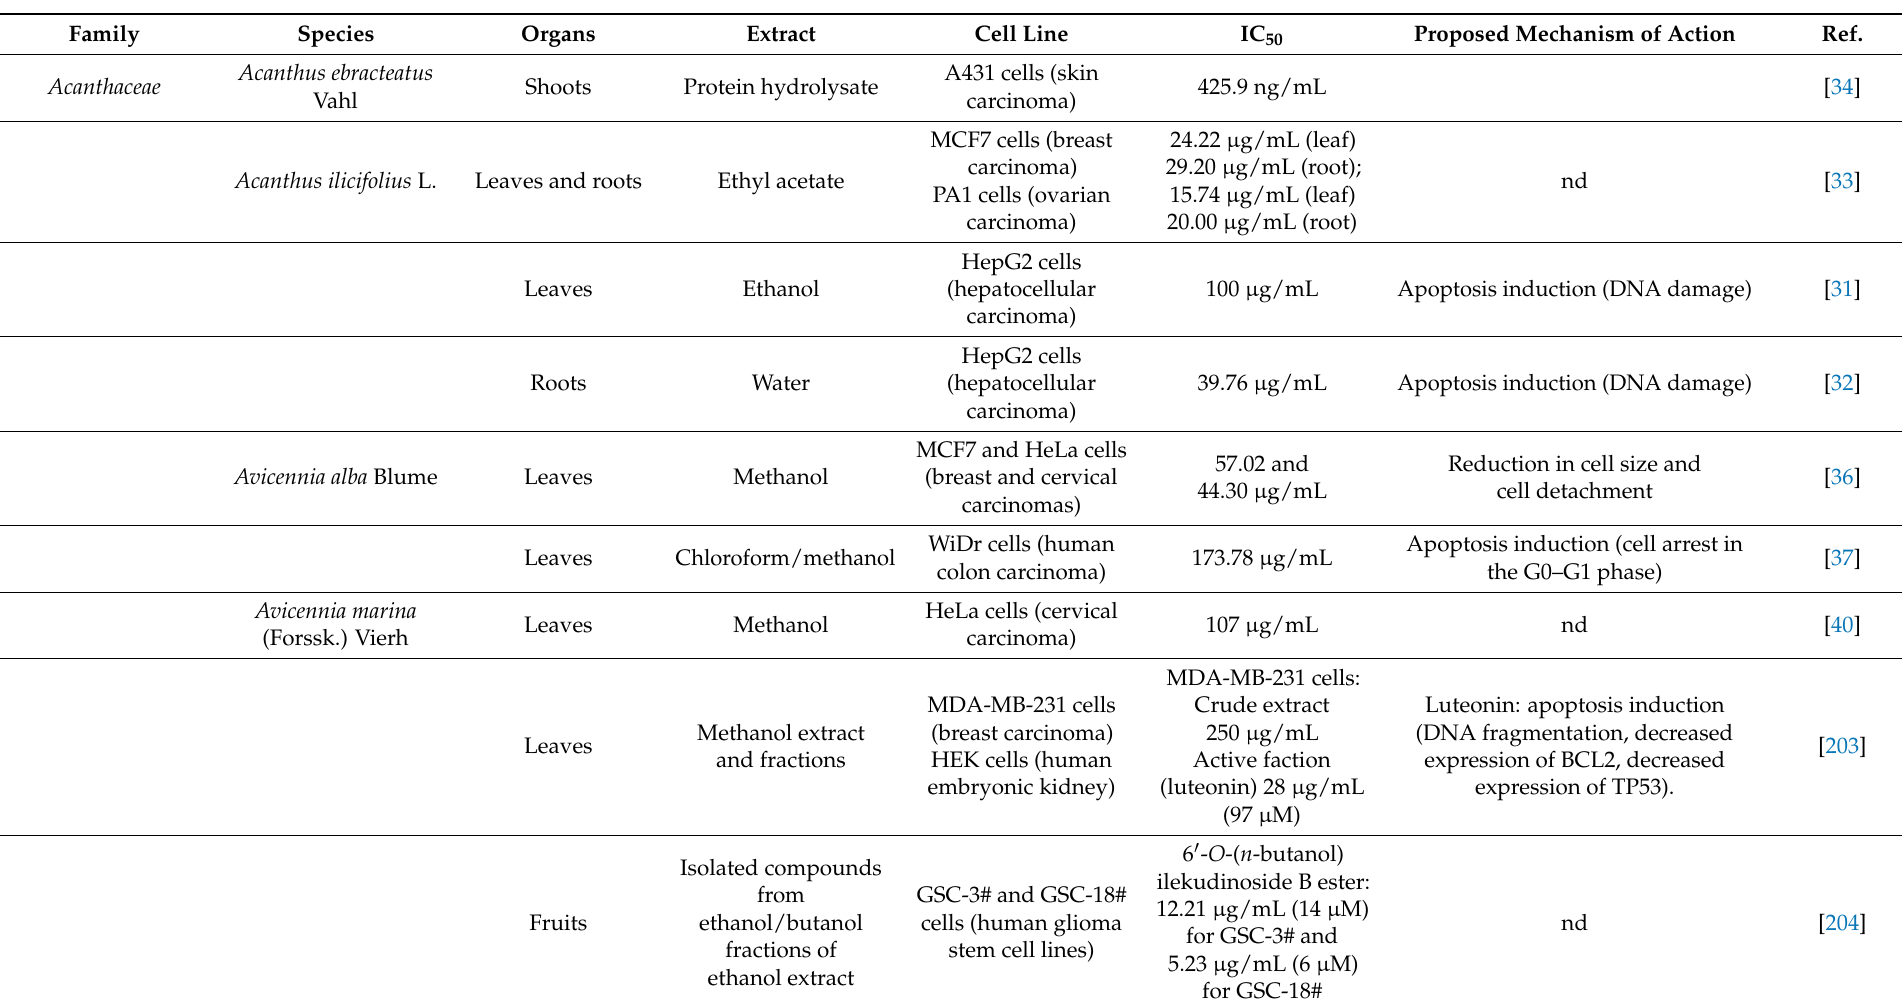
Table 1. List of halophyte species, organs and extracts tested, cell lines/types of cancer assessed, and obtained half-maximal inhibitory concentrations (IC 50 )